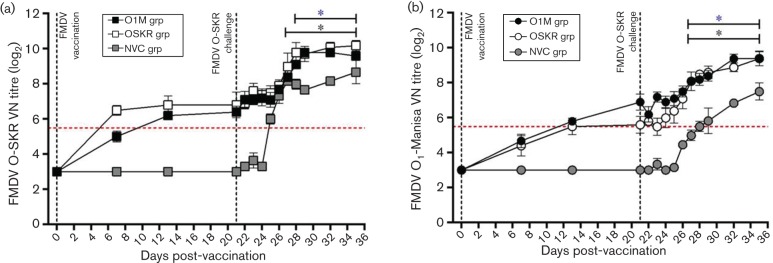
Kinetics of the FMDV-O-serotype-specific virus-neutralizing antibody response in cattle post-vaccination and live-virus challenge. Kinetics of the O-serotype (a) FMDV O-SKR-specific and (b) FMDV O1-Manisa-specific virus neutralization (VN) titre post-vaccination and FMDV-O-SKR live-virus challenge in the FMDV O1-Manisa-vaccinated cohort (black symbols), the FMDV O-SKR-vaccinated cohort (open symbols) and the non-vaccinated controls (grey symbols). Results are expressed as the log10 transformed grouped mean of duplicate determinations from each calf±sd. Statistically significant time points, as compared with 0 dpc (P≤0.05), indicated by * symbol, (FMDV O1-Manisa vaccinated cohort = black, FMDV O-SKR-vaccinated cohort = blue).